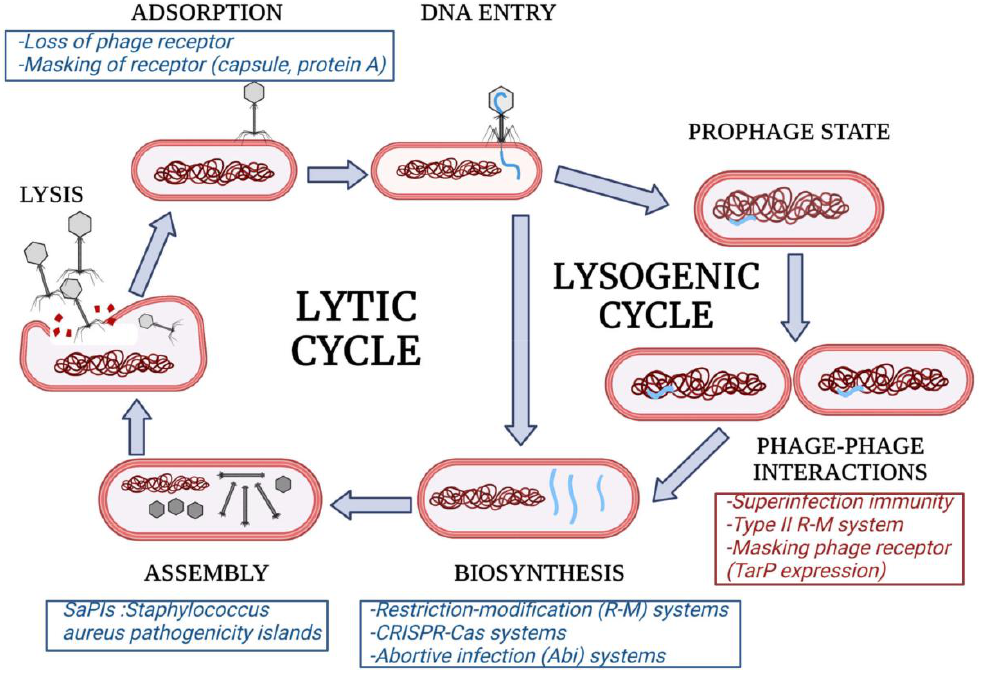
Figure 1. Summary of phage resistance determinants interfering with different stages of the lytic life cycle (blue boxes) and resistance mechanisms encoded in prophages (red boxes).